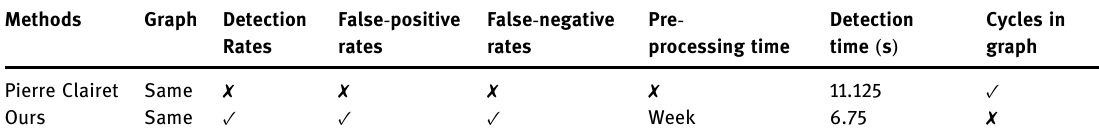
Table 6: Global comparison of the two methods